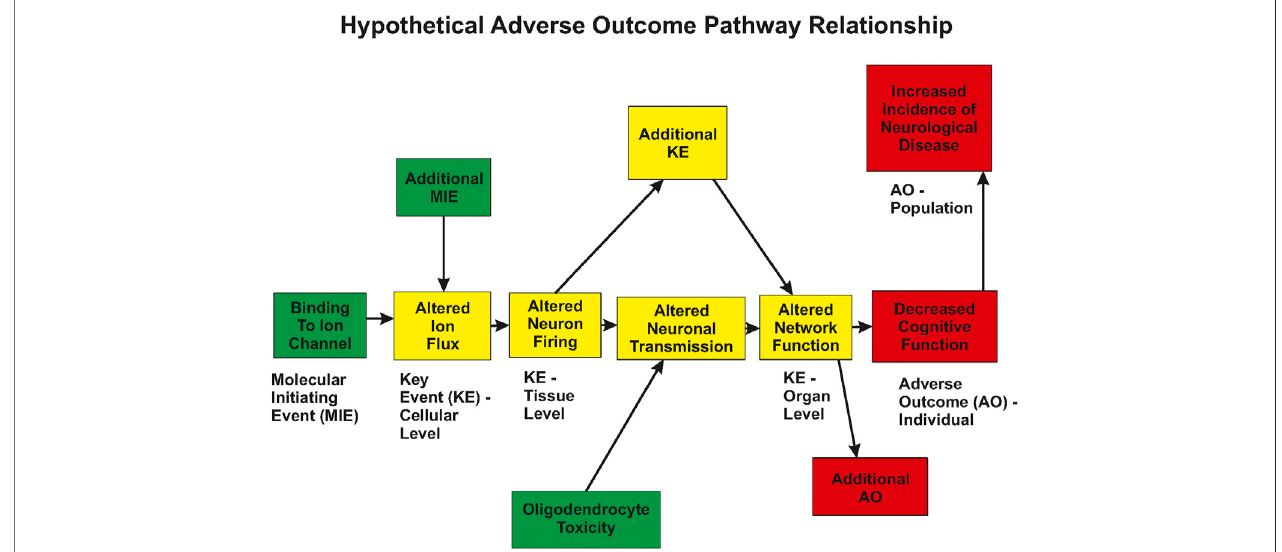
FIGURE 1 | Hypothetical Adverse Outcome Pathway relationship. A xenobiotic interacts with biological tissue and results in a Molecular Initiating Event (MIE). This changeinbiologyproducesanalterationinameasurableKeyEvent(KE),whichinturn,resultsinthesubsequentchangeinadditionalKeyEvents.Thisprogressionleads tomeasurable changesat thecellular, tissue,and organlevelsofbiology. Note thatmultipleMIEscanimpinge onasingle KE,and KEs caninteract inanetworkmanner. Eventually,thebiologyisalteredsuf fi cientlytoresultinanAdverseOutcome(AO)thatisofconcerntosociety.Alteredion fl uxcouldbemeasuredusingpatchclamp techniques, altered neuronal fi ring could be measured using multi-electrode arrays, altered network function could be measured using evoked potentials or EEG measures.